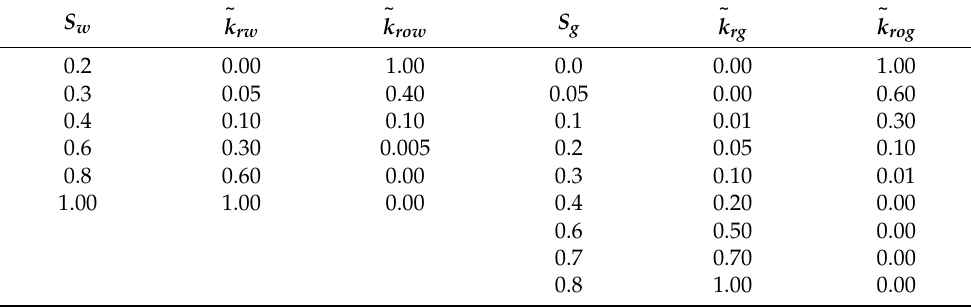
Table 2. Saturation